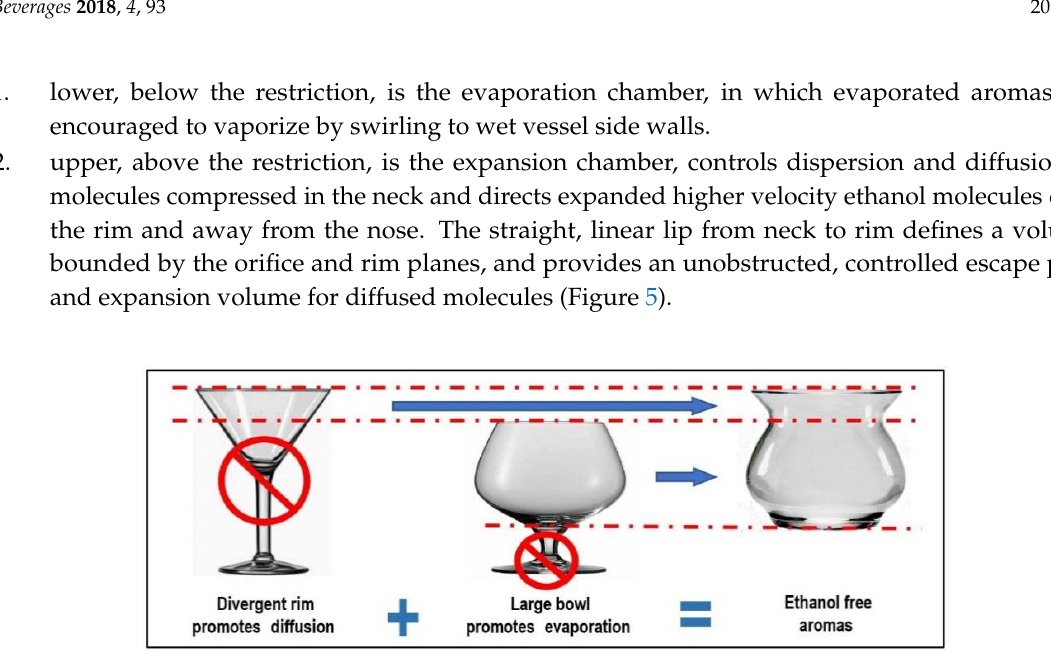
Figure 5. Advantages of combining two shapes. Large convergent vessel bowl improves swirling evaporation, ensuring that more aromas reach the orifice or neck, to be diffused by the divergent expansion chamber. Orifice height of the engineered vessel is well below 2.5 cm.